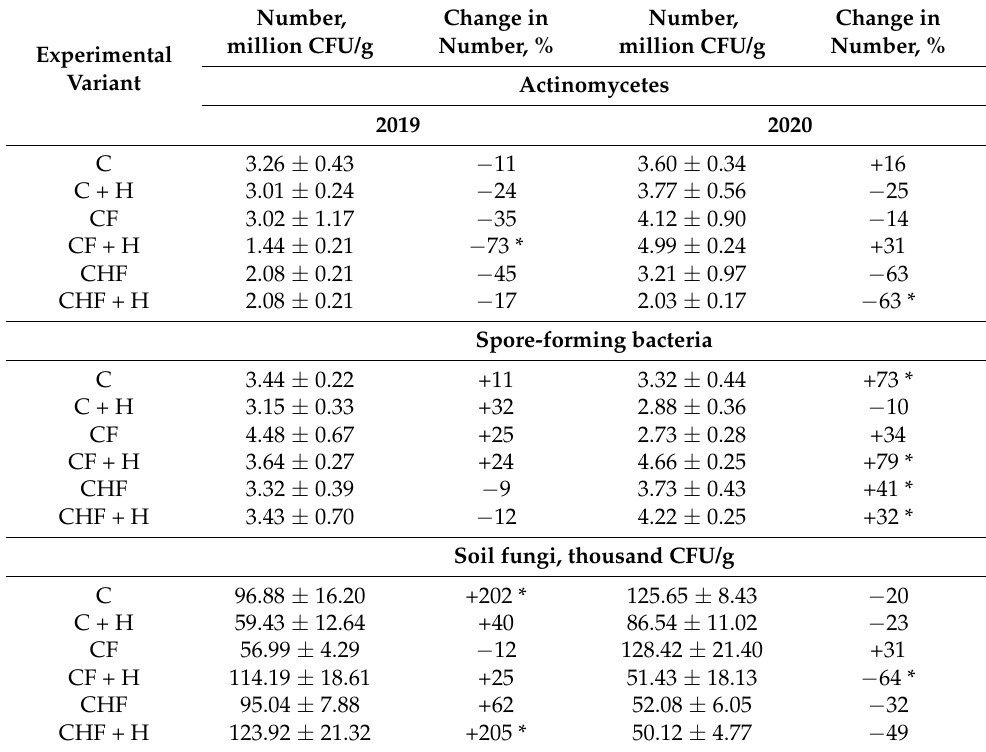
Table 8. The influence of the humic preparation on the number of actinomycetes, spore-forming bacteria, and soil fungi under chickpeas.